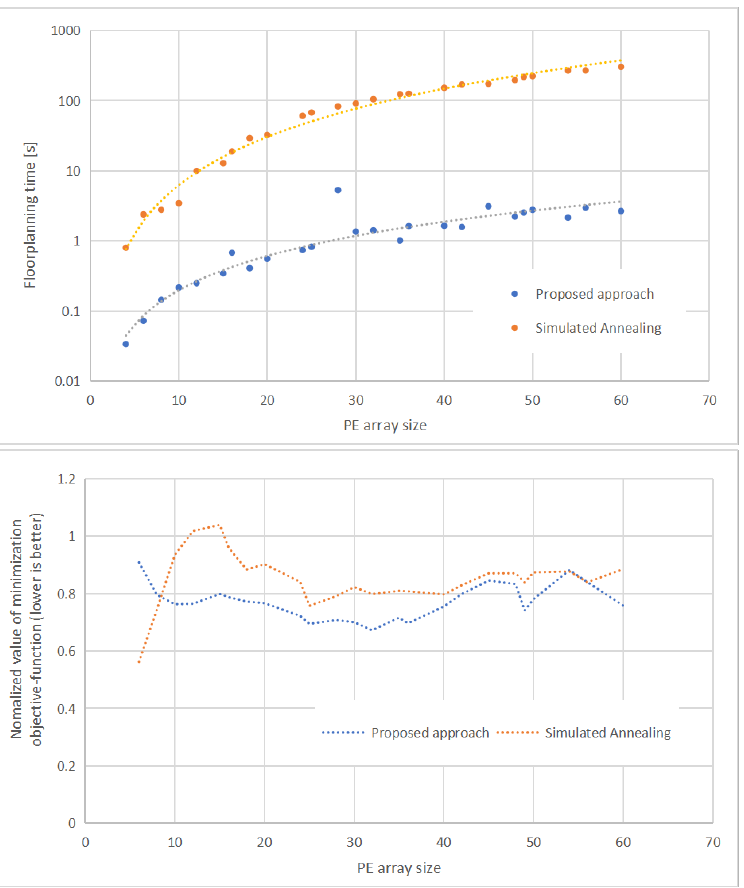
Figure 10. Normalized values of minimization objective-function (lower is better) and floorplanning times for different array